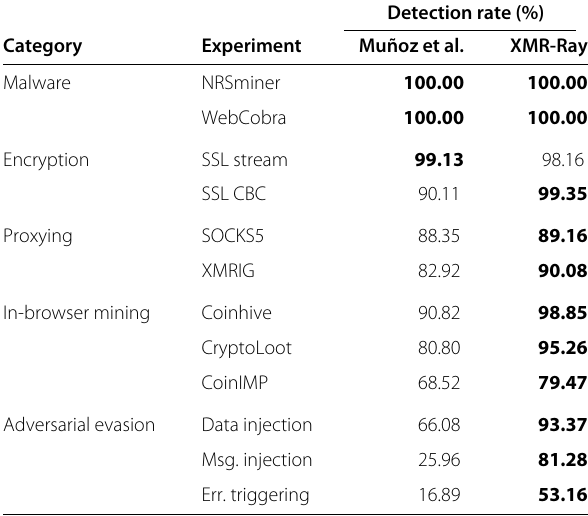
Table 5 Competitive